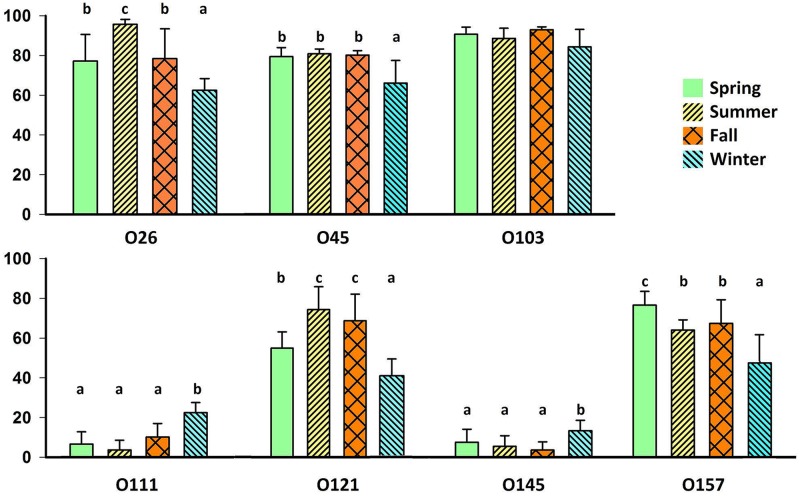
Seasonalz PCR detection of Top Seven serogroups in feces of western Canadian slaughter cattle.Bars indicate 95% confidence intervals. Means within a serogroup with different superscripts differ (P < 0.001). zSeason: spring (March, April, May), summer (June, July, August), fall (September, October, November), winter (December, January, February).